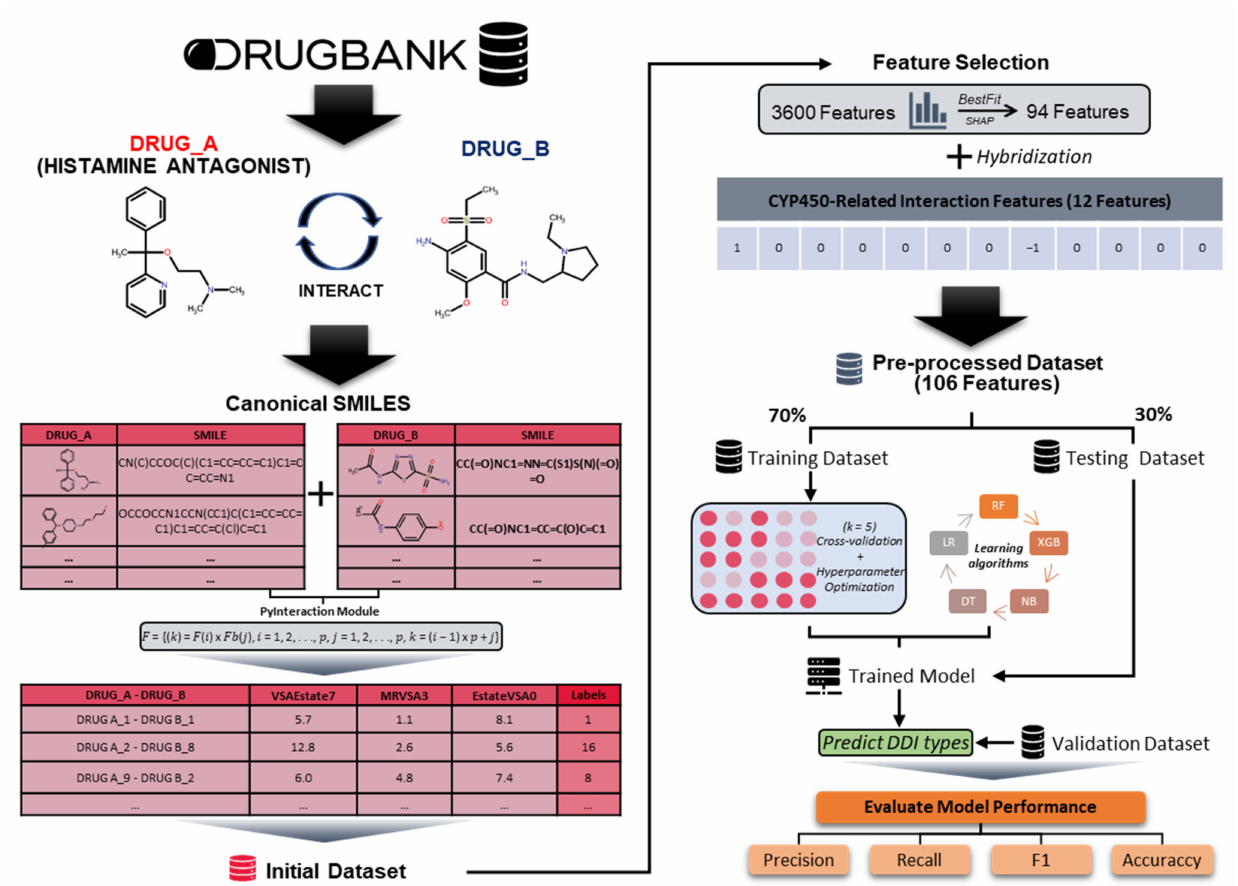
Figure 1. The architecture of the heterogeneous histamine antagonist interaction-network inference (HAINI) framework for predicting multiclass drug-drug interactions